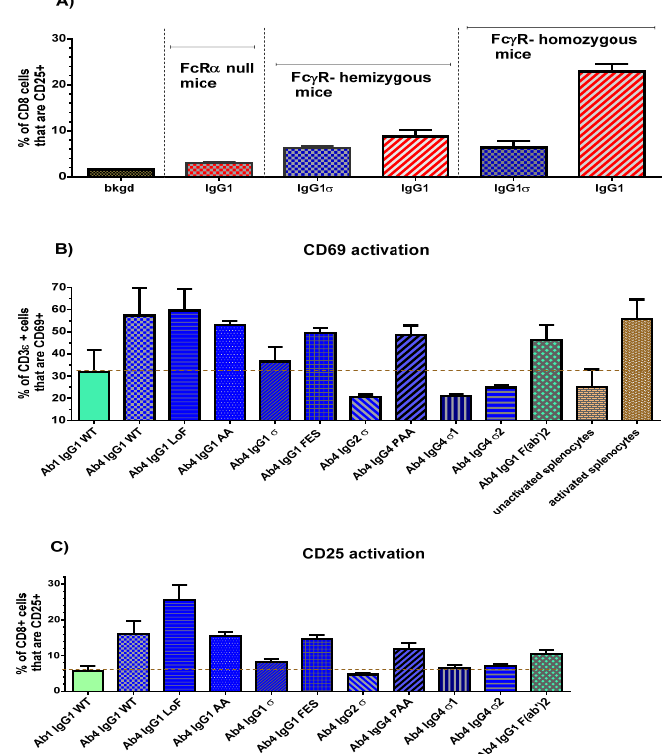
Figure 8. In vivo T cell activation. ( A ) Results of in vivo T cell activation by IgG1 σ relative to wild-type IgG1. Fc γ R-humanized mice, homozygous and hemizygous, and mice lacking Fc γ Rs (null) were injected intraperitoneal with a 0.5 mg/kg dose of either human IgG1 σ or wild-type IgG1. After 24 h, spleens were collected from each mouse and the percent of CD8+ cells (as well as CD3 ε cells, not shown) that stained positive for CD25 was measured by flow cytometric analyses. ( B ) Comparison of in vivo T cell CD69 activation with panel of silent IgG Fc variants. ( C ) Comparison of in vivo T cell CD25 activation with panel of silent IgG Fc variants. The dashed line represents the level of non-specific activation, derived from the mean value of un-activated splenocytes and splenocytes treated with a control IgG1 WT. Error bars represent the standard error of mean from 3 to 6 samples in both studies.